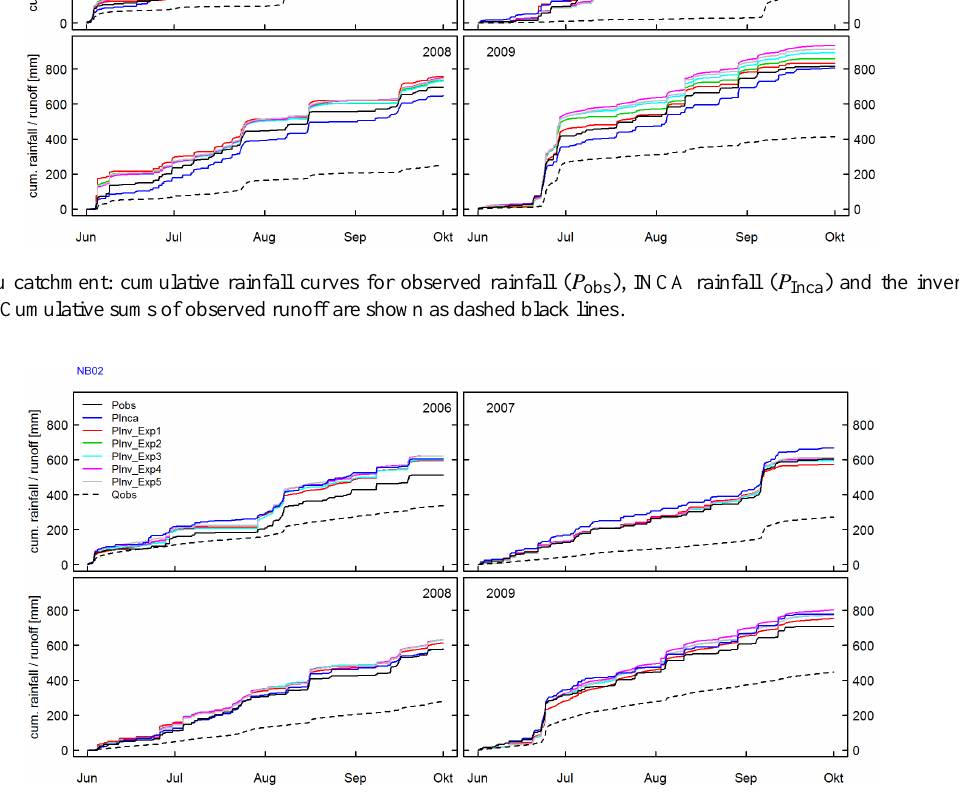
Figure 9. Krems catchment: cumulative rainfall curves for observed rainfall ( P obs ), INCA rainfall ( P Inca ) and the inverse rainfall of Exp 1 – Exp 5 . Cumulative sums of observed runoff are shown as dotted black